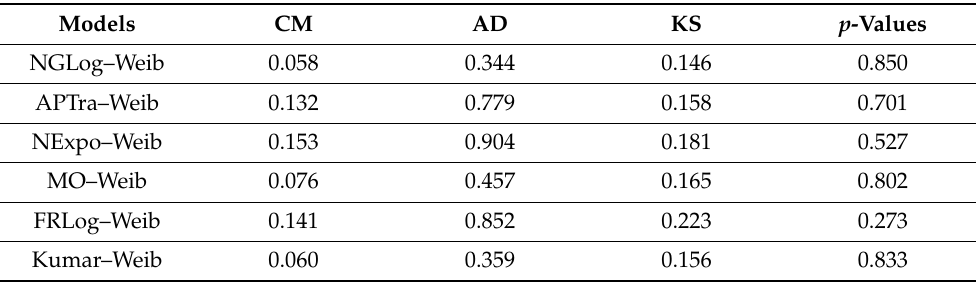
Figure 10. For dataset 4, the ( a ) histogram, ( b ) kernel density plot, ( c ) TTT plot, ( d ) violin plot, and ( e ) box plot. Table 16. The GFMs and p -values of the competing models for the patients receiving analgesics’ data (dataset 4). Table 15. The